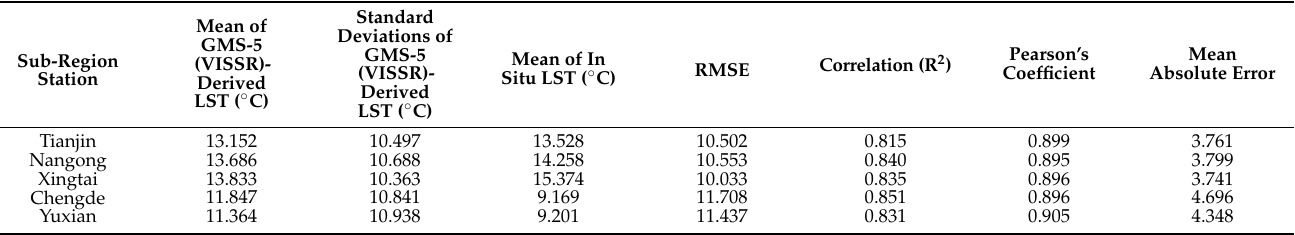
Table 2. Correlation analysis of the remote sensing-retrieved data and the in situ values at five stations in the Beijing–Tianjin–Hebei